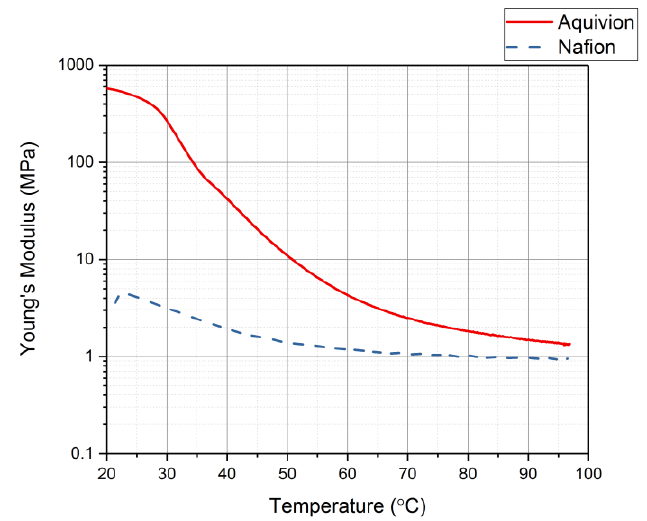
Figure 15. Damping coefficient as the temperature increases to find the glass transition temperature range for the precursor ionomers.